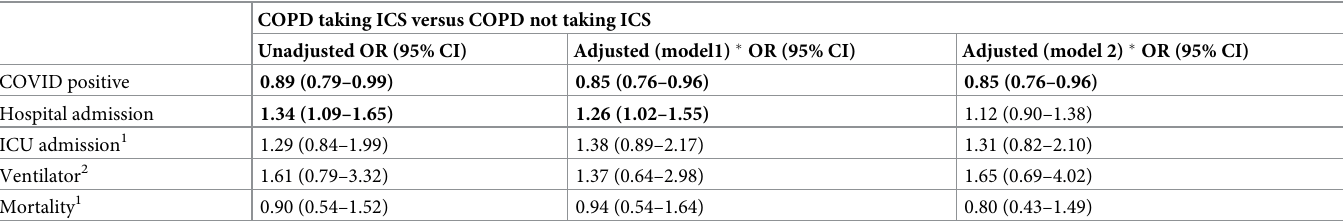
Table 4. Multivariate logistic regression analysis of COPD patients comparing those on ICS versus those not on ICS. COPD taking ICS versus COPD not taking ICS